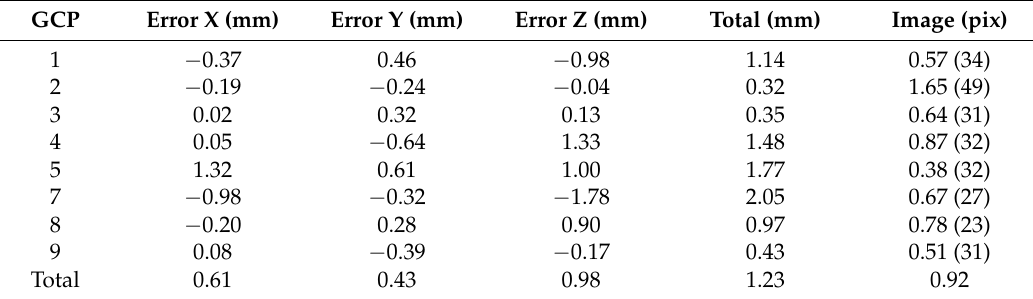
Table 4. Control points of images not filtered and not geometrically calibrated.